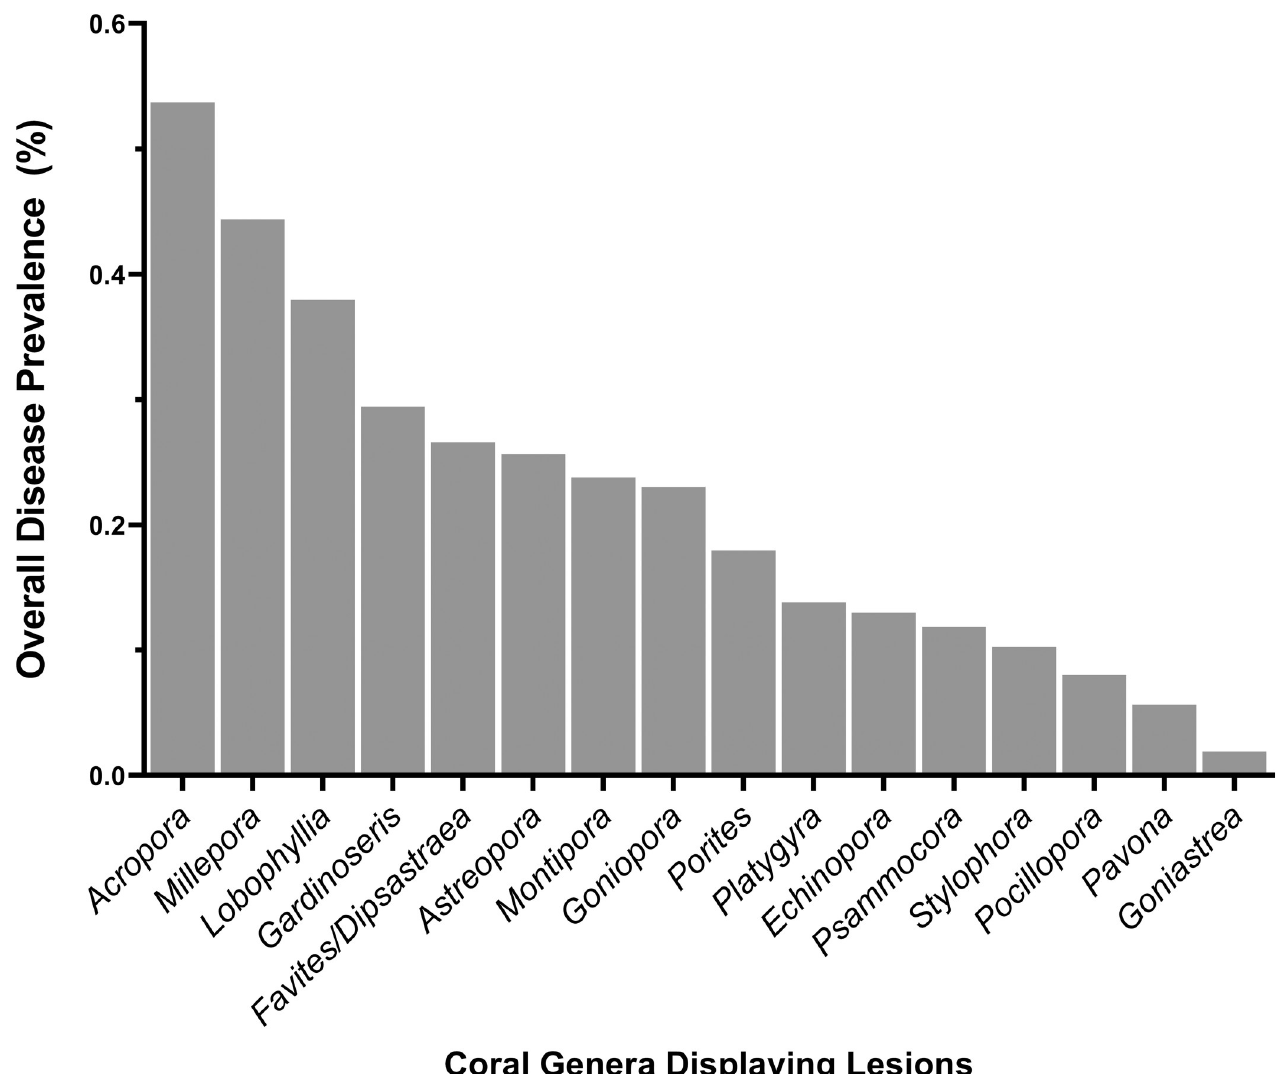
Fig 7. Differences in overall disease prevalence among coral taxa. Data show overall prevalence with all surveys